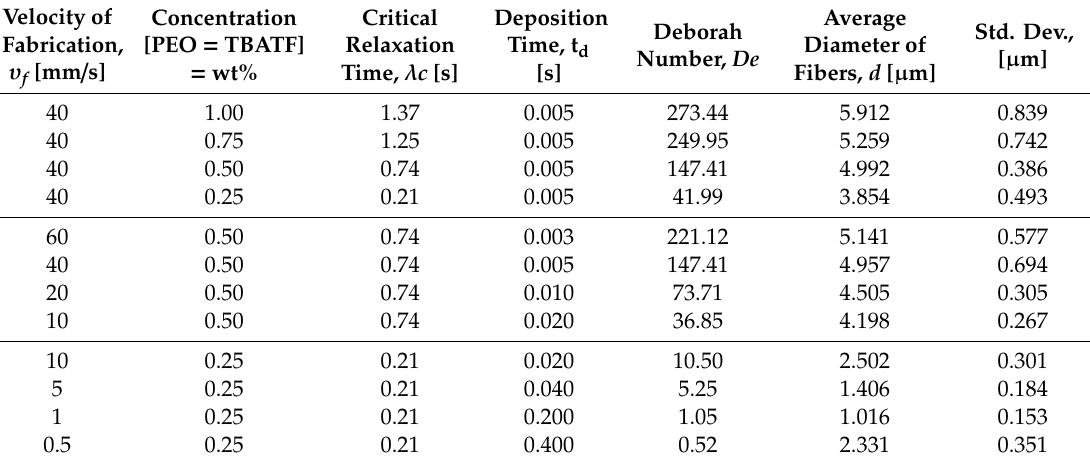
Table 5. Summary of fiber